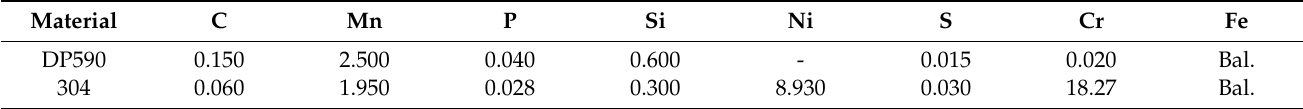
Table 1. Chemical composition of DP 590 and 304 stainless steel (mass score/%).